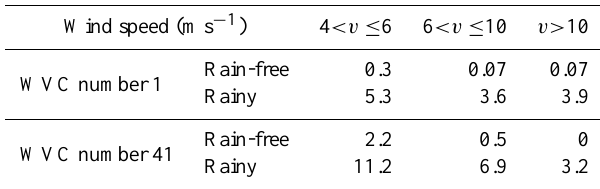
Table 1. The percentage of triplets with rejected high-rank solutions that were selected by the AR module. WVC number 1 corresponds to highest incidence angle (outer-swath WVC), and WVC number 41 corresponds to lowest incidence angle (near-swath